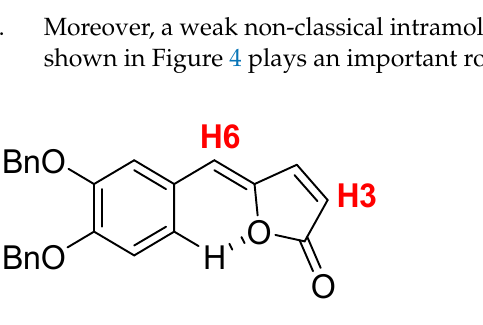
Figure 4. Intramolecular hydrogen bond that stabilizes the Z -isomer ( 2a ).